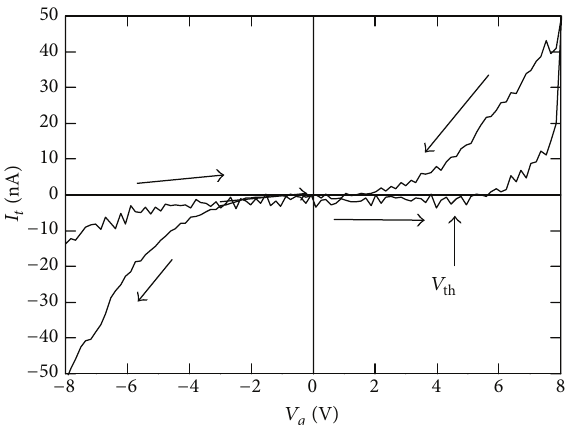
Figure 2: A typical cyclic 𝐼 - 𝑉 curve of AFM probe contact to YSZ/Si film measured at 𝑉 𝑚 = 8 V. The arrows denote the direction of 𝑉 𝑔